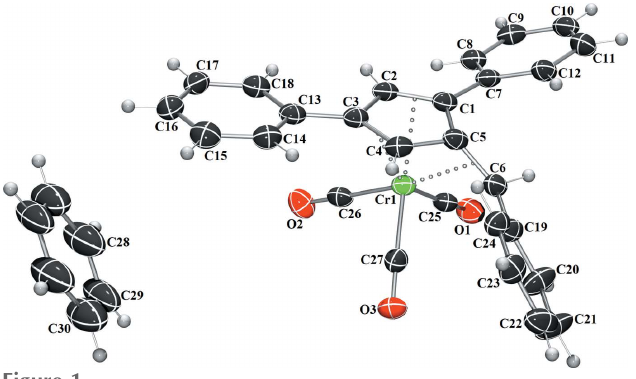
Figure 3 The molecular structure of III . Displacement ellipsoids are shown at the 50% probability level.